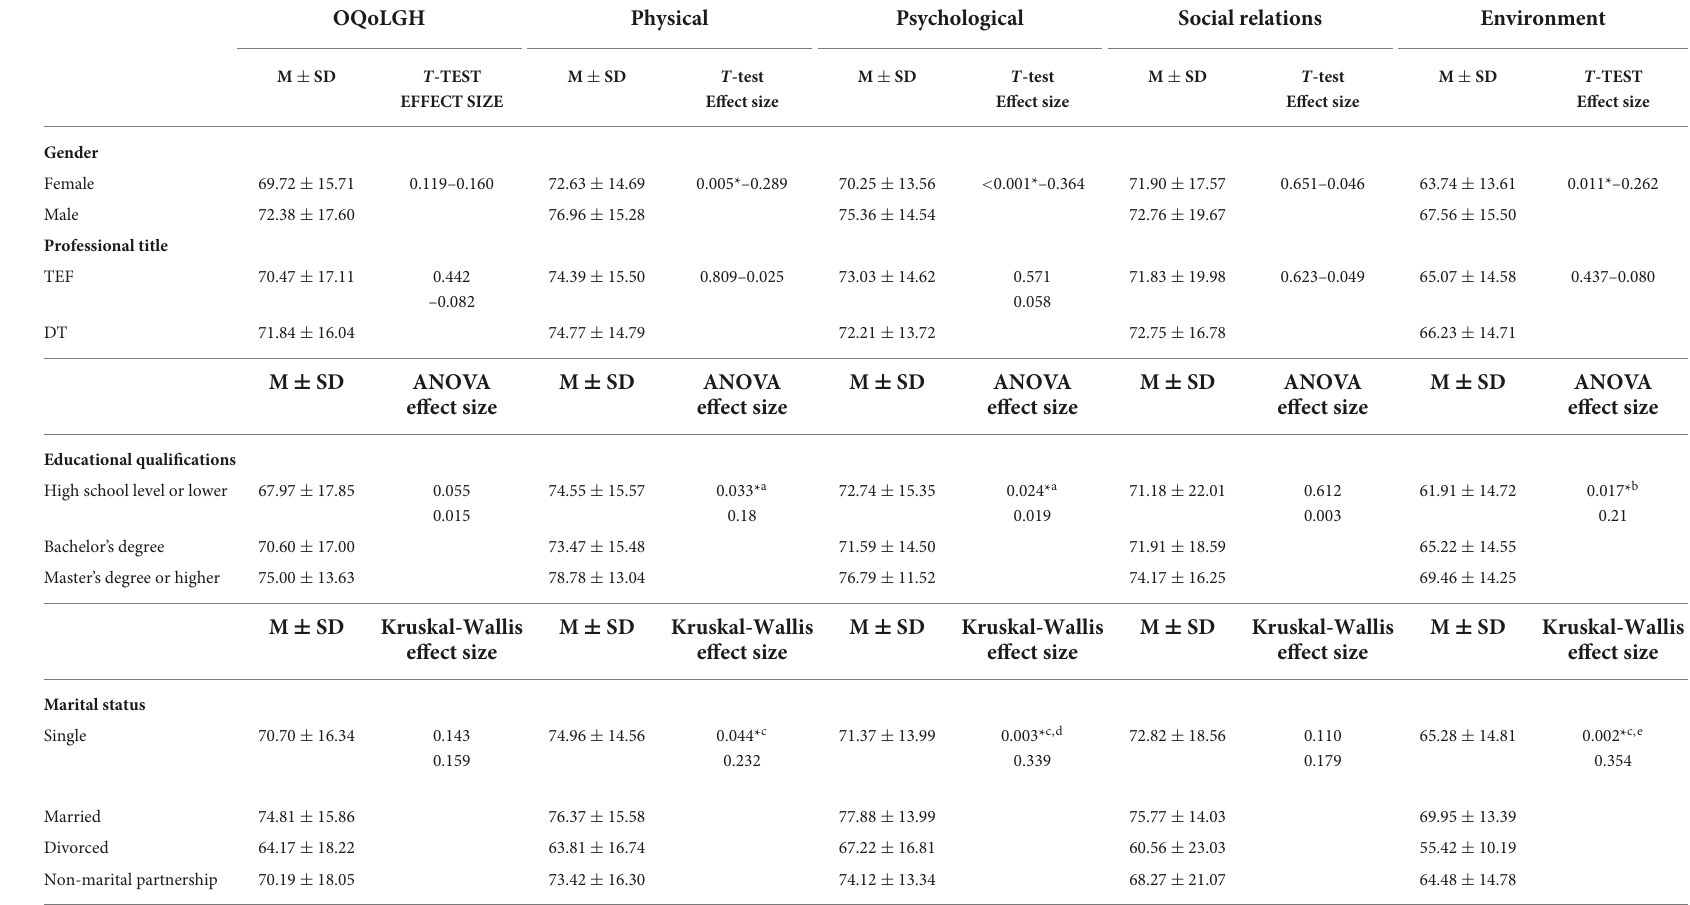
TABLE 3 Comparative statistics of QoL between